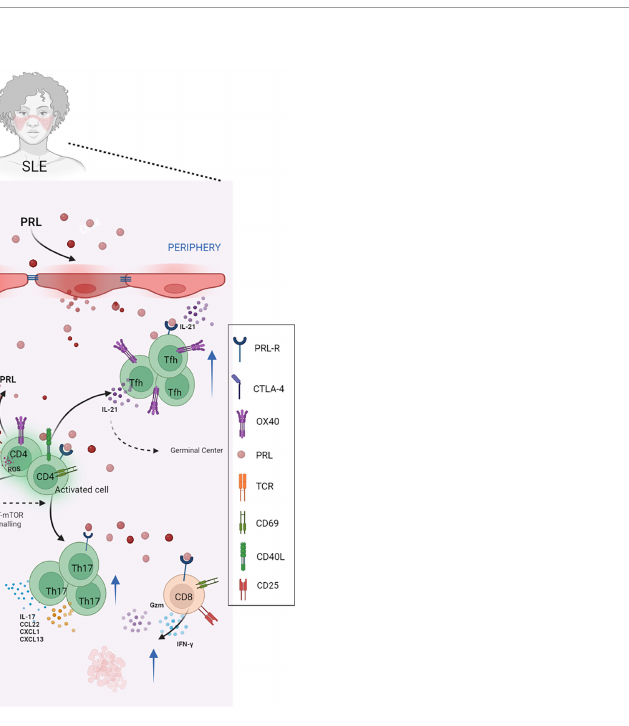
FIGURE 1 PRL in T cells and SLE. PRL exacerbates the mechanisms of activation and differentiation of T helper lymphocytes, mainly towards Tfh, Th17, and Th1 lymphocytes, and reduces the functional capacity of regulatory T lymphocytes, which are already reduced in SLE. In patients with SLE, IL-21 blocks Treg differentiation and function by being activated in a STAT3-dependent manner. These patients also have a higher percentage of circulating CD4+ OX40+ T cells and Th17 cells, as well as increased serum levels of IL-17, which correlates with disease activity. PRL contributes to the secretion of proin fl ammatory cytokines, such as IFN g , and the expression of activation molecules, such as CD69 and CD40L, as well as the cytotoxic activity of CD8+ T cells, favoring the availability of autoantigens and, therefore, the phenomenon of autoimmunity (Created with